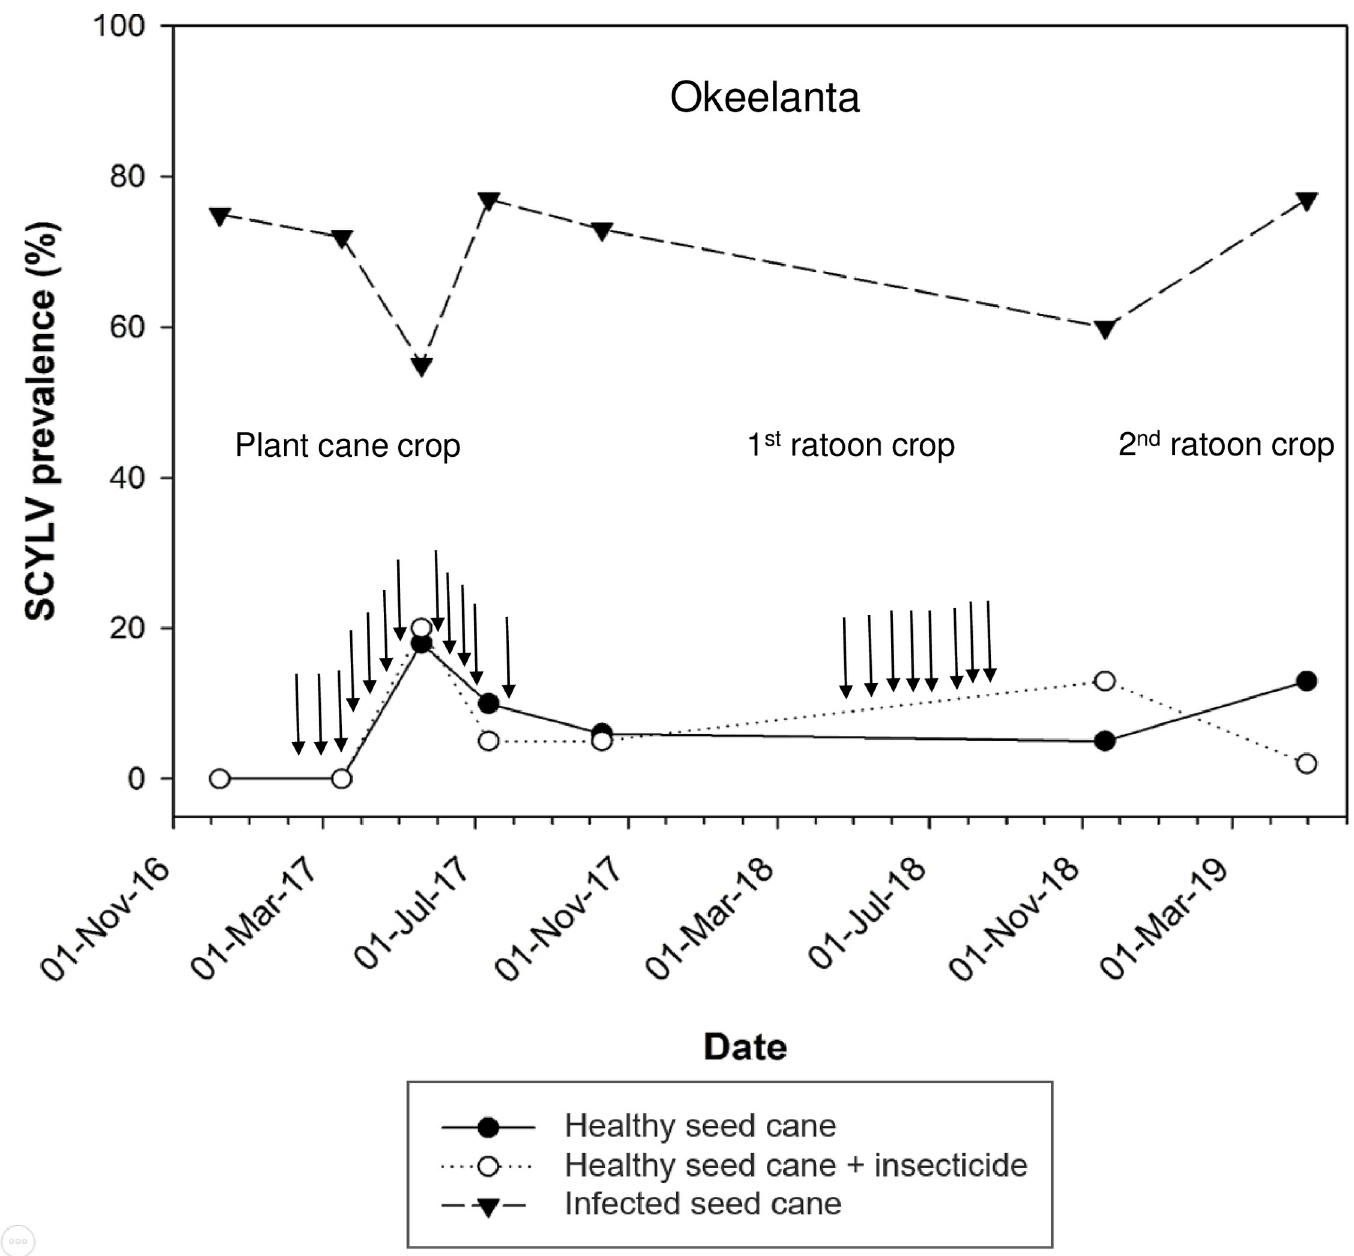
Fig 2. Progress of prevalence of sugarcane yellow leaf virus (SCYLV) in sugarcane cultivar CP96-1252 grown on organic soil (at Okeelanta). Sugarcane was planted on 8 December 2016 and harvested at the end of the plant cane crop on 28 January 2018. Sugarcane was harvested in the first ratoon crop on 2 December 2018. Prevalence of SCYLV was determined from December 2016 to May 2019. Insecticide was applied in the plant cane crop at the following dates (vertical arrows): 13 February 2017, 28 February 2017, 16 March 2017, 29 March 2017, 12 April 2017, 26 April 2017, 9 May 2017, 23 May 2017, 6 June 2017, 20 June 2017, 5 July 2017 and 19 July 2017. Insecticide applications were performed in the first ratoon crop at the following dates (vertical arrows): 2 May 2018, 21 May 2018, 4 June 2018, 19 June 2018, 7 July 2018, 31 July 2018, 16 August 2018 and 29 August 2018. Each data point represents the mean percent of infection of six plots (10